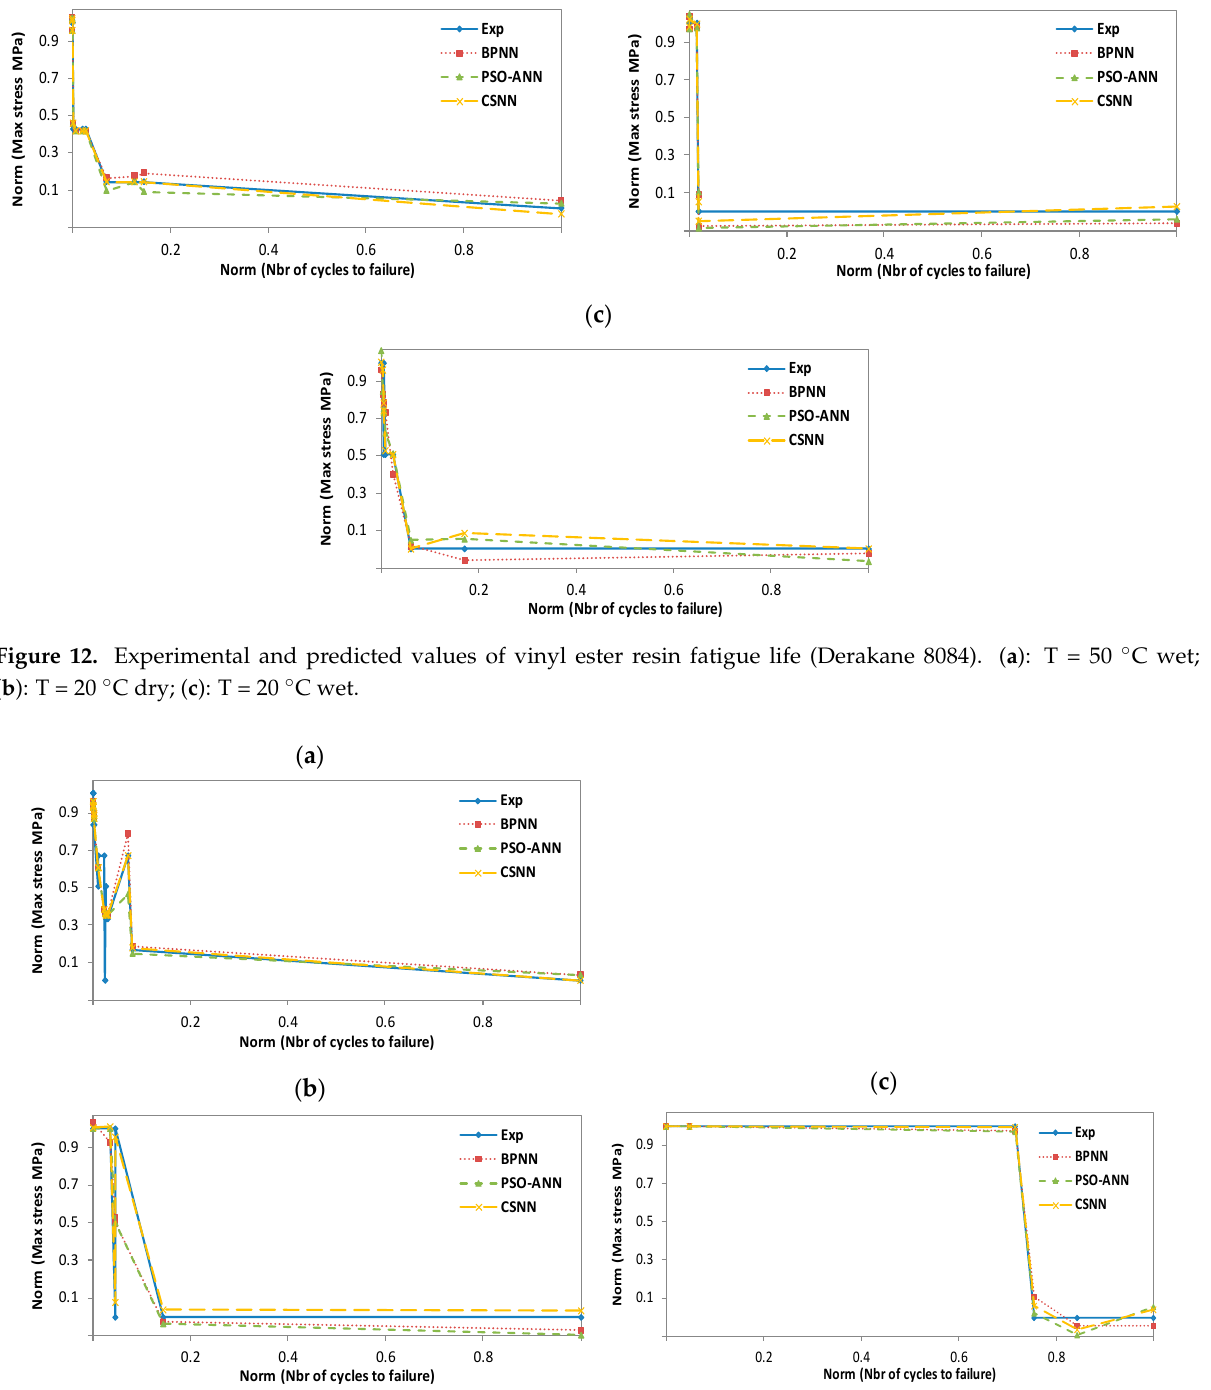
Figure 13. Experimental and predicted values of iso-polyester resin fatigue life (CoRezyn 75-AQ-010). ( a ): T = 50 ◦ C wet; ( b ): T = 20 ◦ C dry; ( c ): T = 20 ◦ C